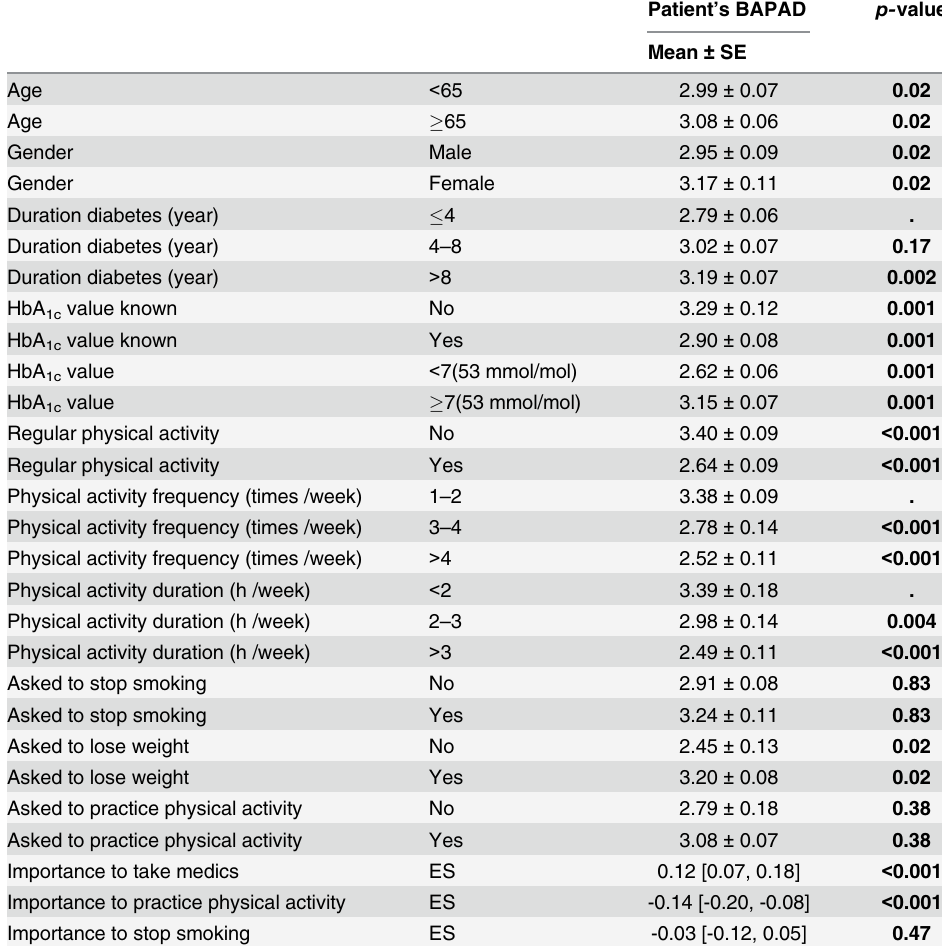
Table 3. Patient ’ s BAPAD according to patient ’ s characteristics (univariate mixed model).